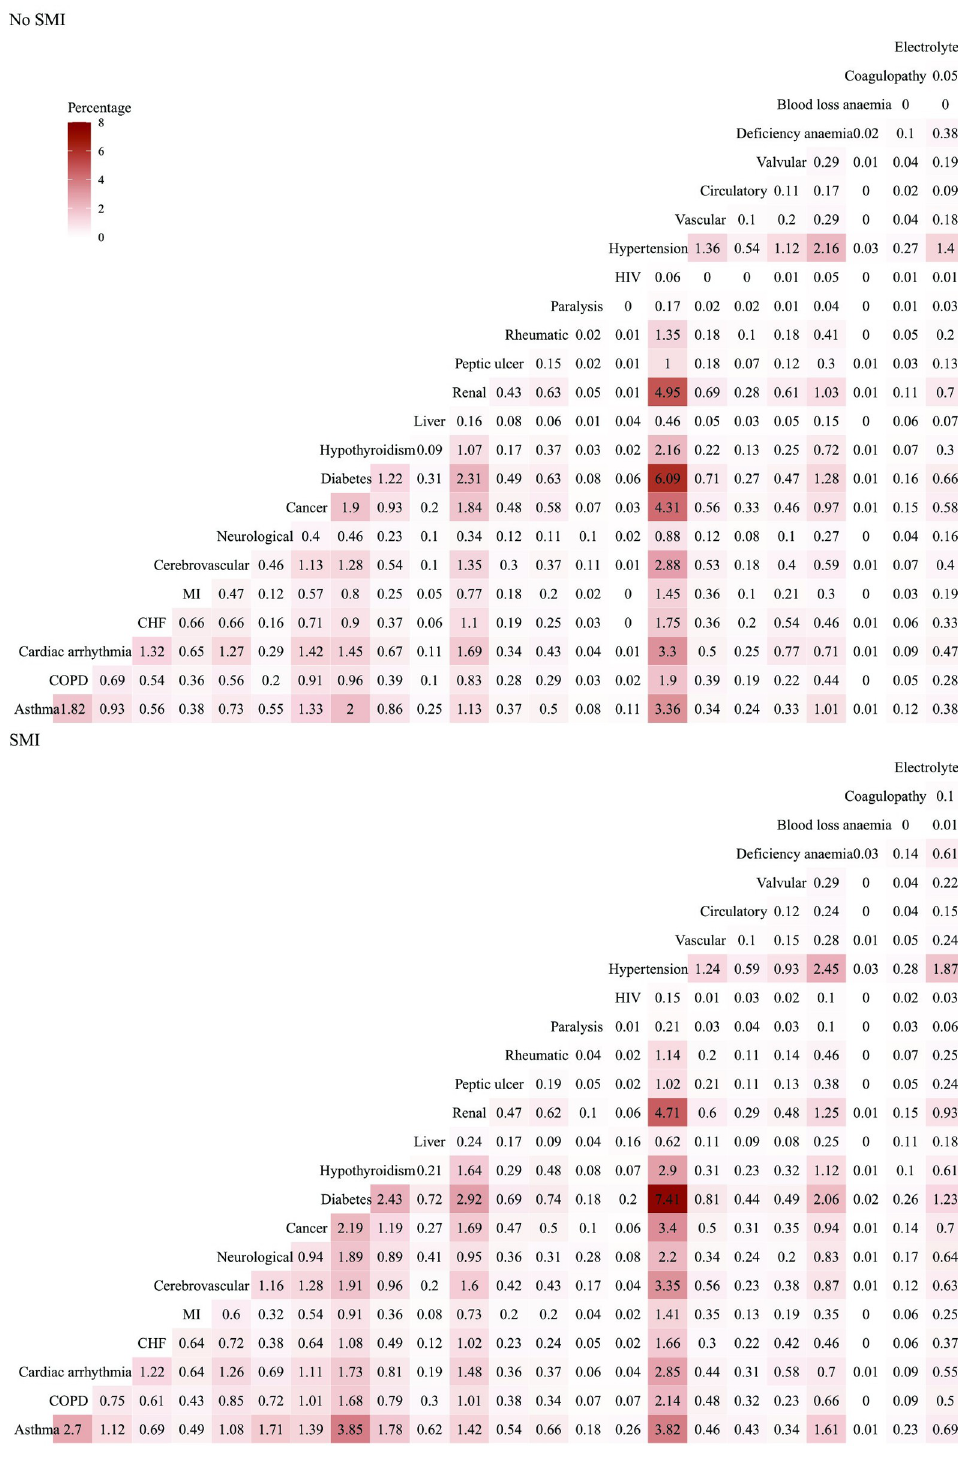
PLOS Medicine| https://doi.org/10.1371/journal.pmed.1003976 April 20,